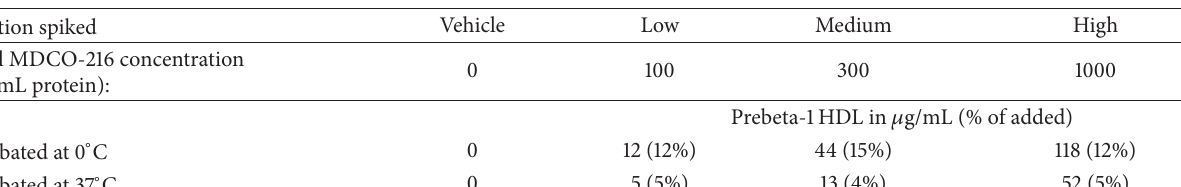
Table 1: Prebeta-1 HDL as measured by ELISA in MDCO-216 solutions mixed with buffer or plasma after 1h incubation at 0 or 37 ∘ C. MDCO-216 stock solution contained 13 mg/mL ApoA-I Milano dimer, 6% sucrose, 1% mannitol, and phosphate buffer pH 7.4. Vehicle solution contained 6% sucrose, and 1% mannitol in phosphate buffer, pH 7.4. Solution High (10mg/mL protein) was prepared by